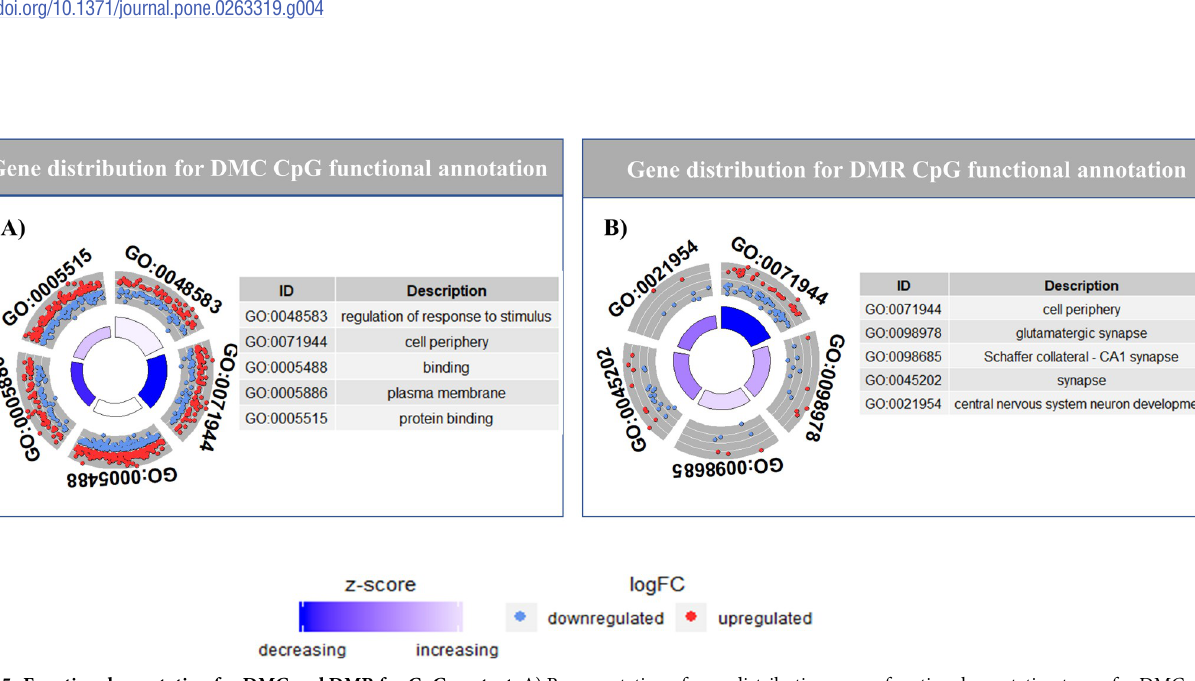
PLOS ONE | https://doi.org/10.1371/journal.pone.0263319 May 12, 2022 10 /